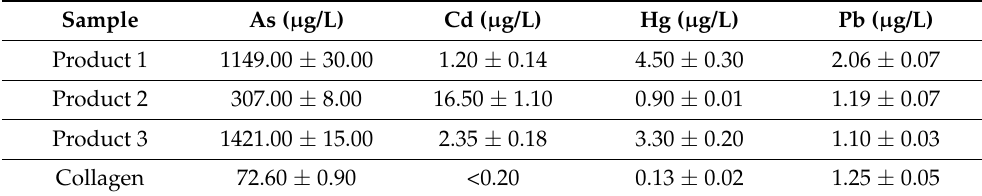
Table 4. Metal content before simulated gastrointestinal digestion of product 1, product 2, product 3 and collagen.